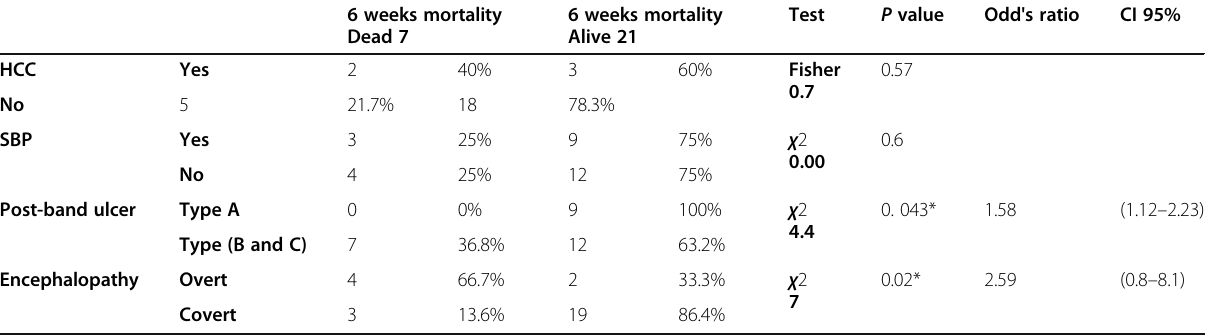
Table 4 Clinical data related to 6 weeks mortality